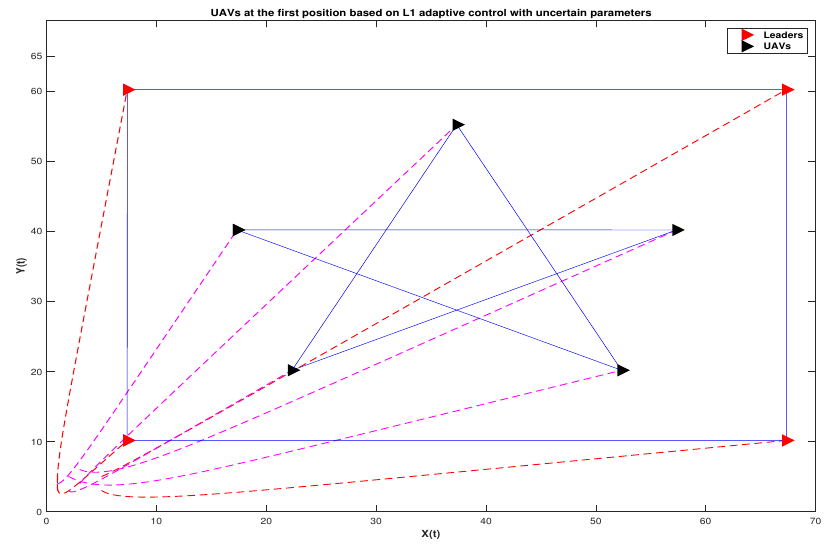
Figure 9. UAVs containment at the first position based on L 1 adaptive control with parameters uncertain.